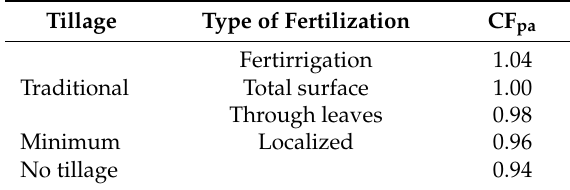
Table 4. Control classes for agronomic practices (CF pa